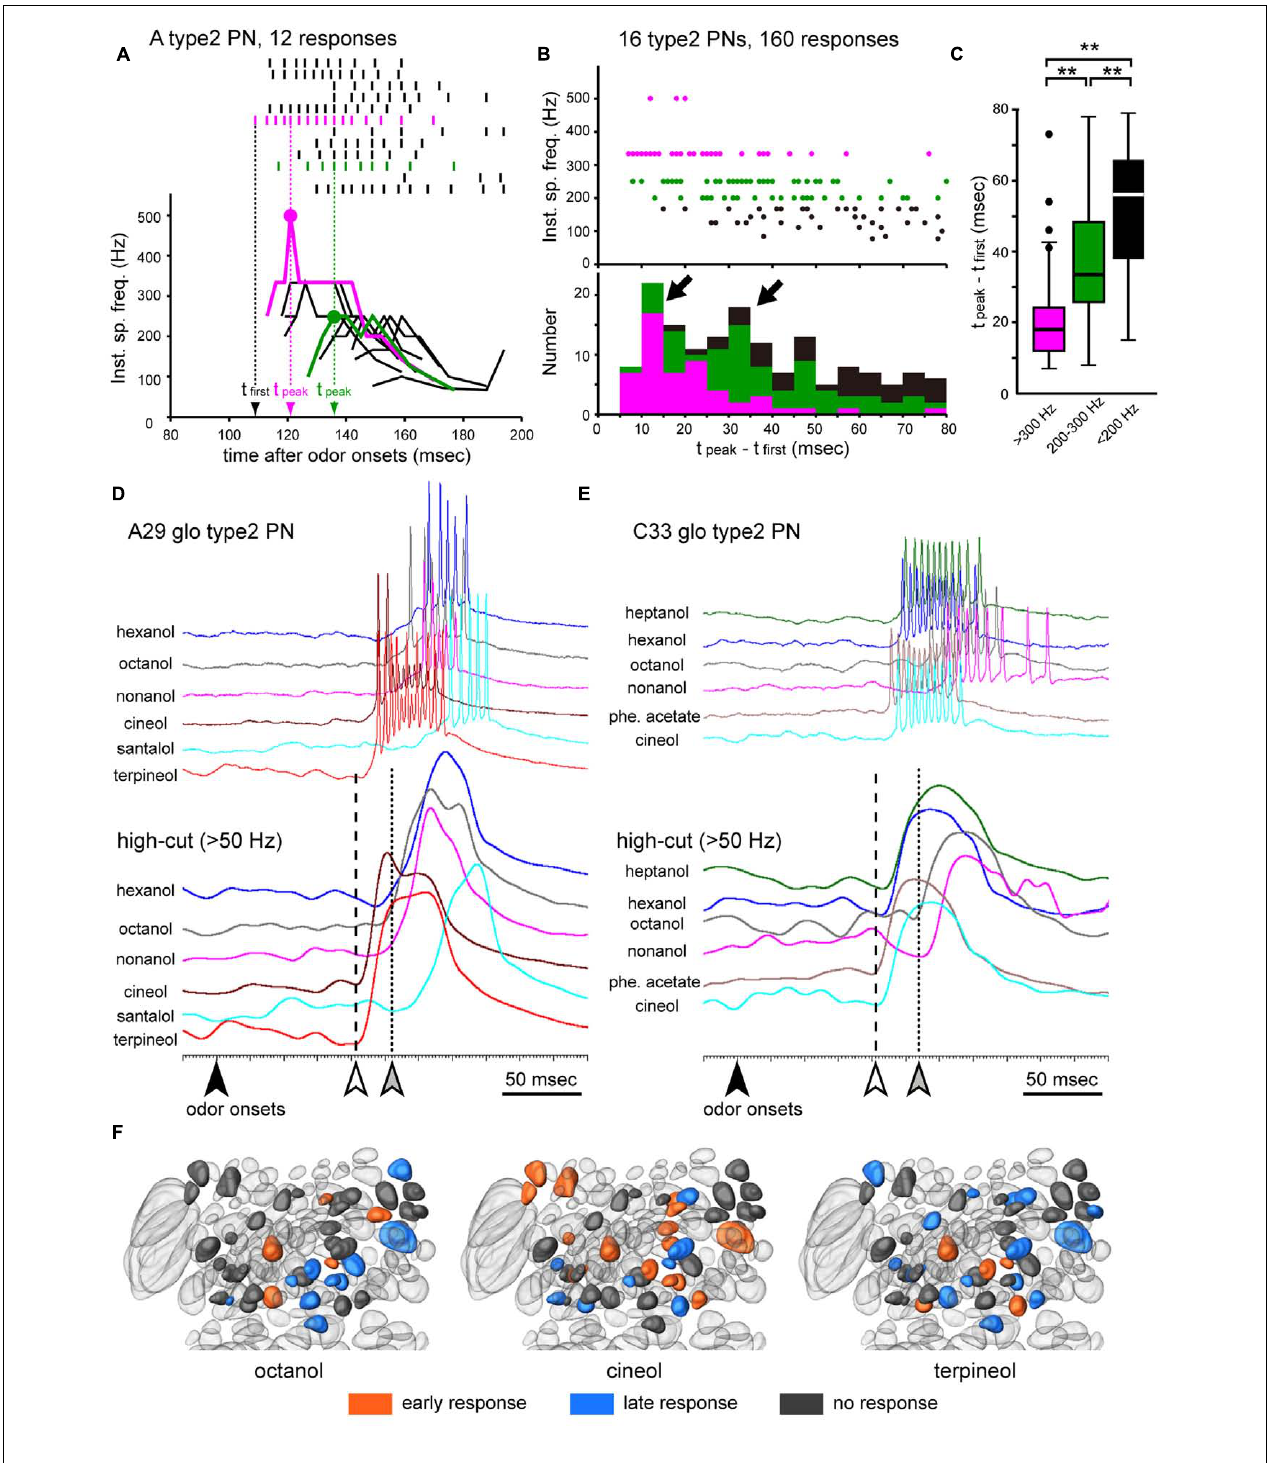
FIGURE 7 | Early and late responses in type2 PNs. (A) Temporal dynamics in odor-induced action potentials of a type2 PN. On-phasic responses to six different odors (12 responses) are shown as raster plots (top) and time-courses of instantaneous spike frequencies (bottom). In each response, we identified a “peak spike” (dots; see “Materials and Methods”). Magenta and green responses indicate typical early and late responses, respectively. (B,C) Time distribution of peak spikes obtained from 160 responses. We identified peak spikes from 160 olfactory responses recorded from 16 different type2 PNs. The timing of each peak spike is corrected as follows; t peak – t first , where t peak is a time of the peak spike from odor onset and t first is a time of earliest odor-induced spike in the specimen